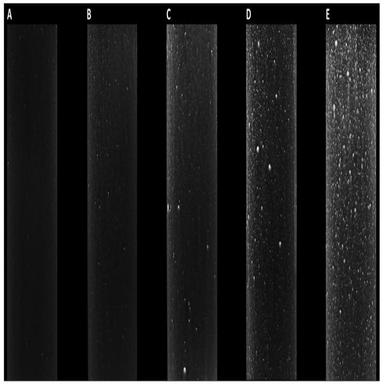
SDP photographic standard. A reconstituted sample is poured into a test tube, the tube is inverted and after a standardised time, the material adhering to the tube is compared with this photographic standard.